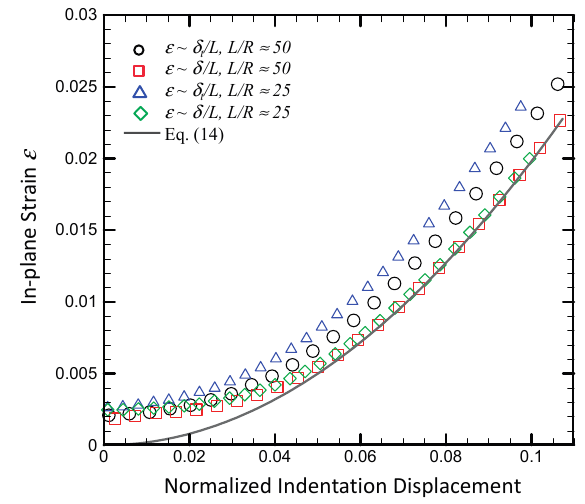
Figure 8. Relationship between indentation displacements (displayed as δ respectively) and in-plane strain of monolayer graphene under free standing indentation calculated from molecular mechanics (MM) simulations. δ indenter tip and graphene, respectively. The solid lines are the fitting curves of Equation